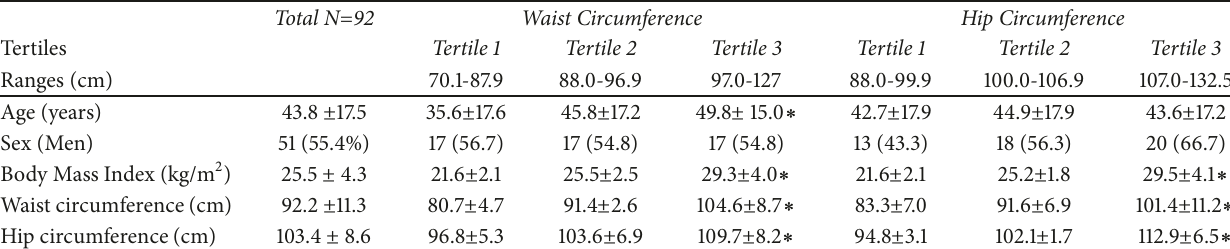
Table 1: Participants’